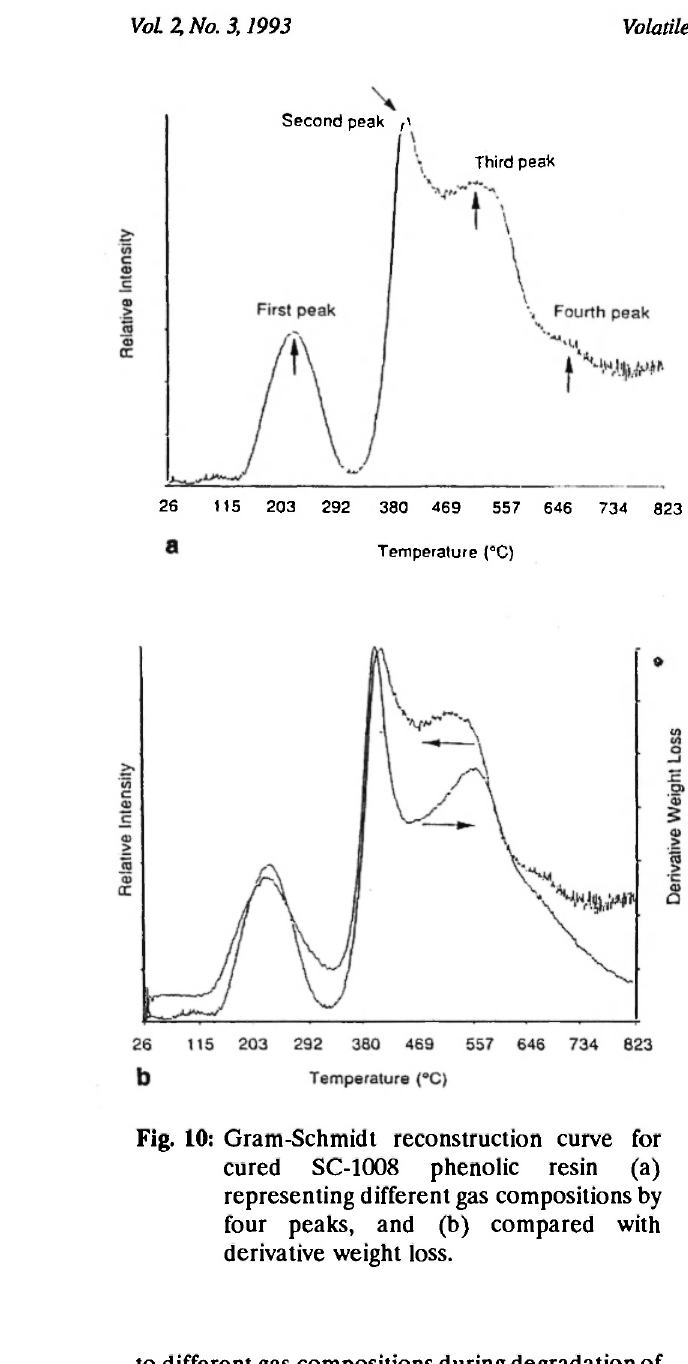
Fig. 10: Gram-Schmidt reconstruction curve for cured SC-1008 phenolic resin (a) representing different gas compositions by four peaks, and (b) compared with derivative weight